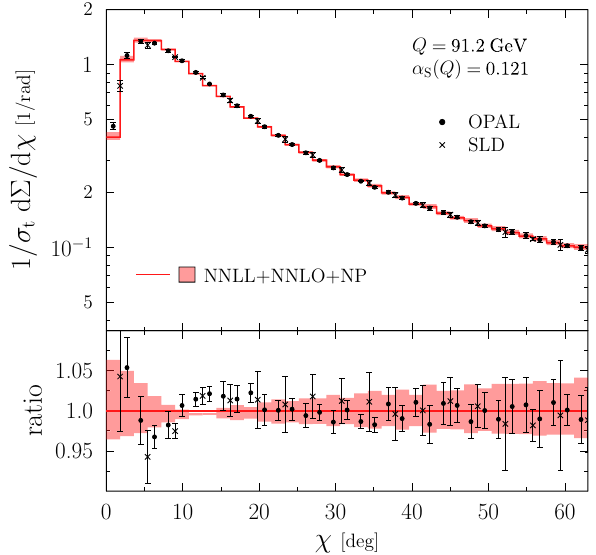
Fig. 7 NNLL + NNLO matched prediction for EEC. The analytic model of Eq. (4.1) is used to account for hadronization corrections. The bottom panel shows the ratio of the data to the matched result. The band represents renormalization scale variation in the range μ ∈ [ Q / 2 , 2 Q ] with three-loop running of α